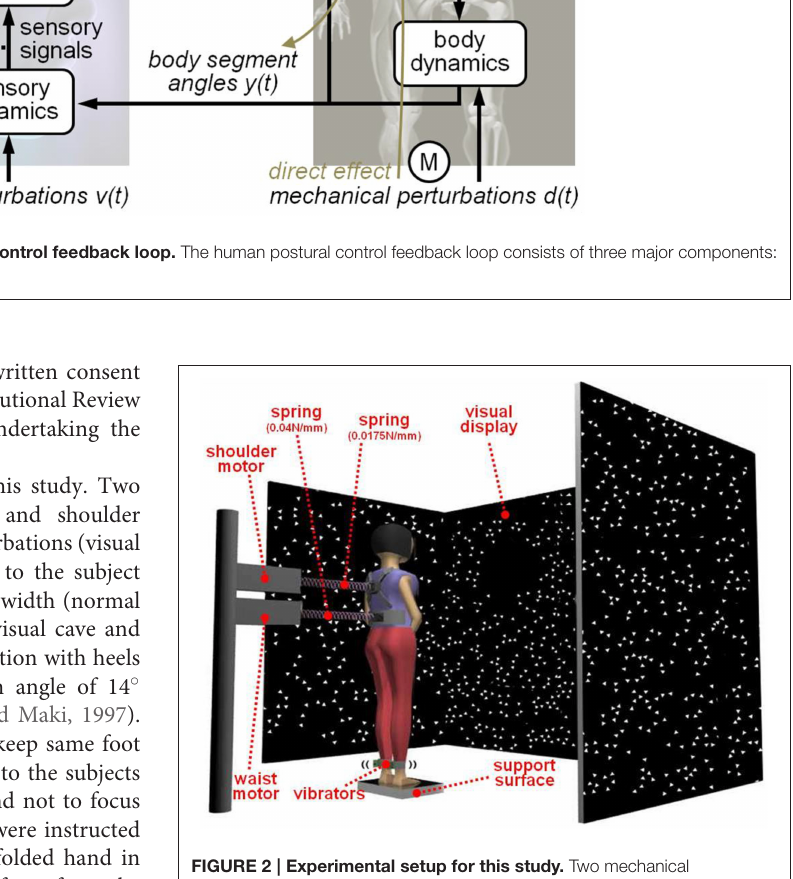
FIGURE 2 | Experimental setup for this study. Two mechanical perturbations (waist and shoulder perturbation) and two sensory perturbations (visual and proprioceptive perturbations) were applied to the subject during standing. Subjects stood on different two width (normal or short) support surface in the middle of the visual cave and faced the front